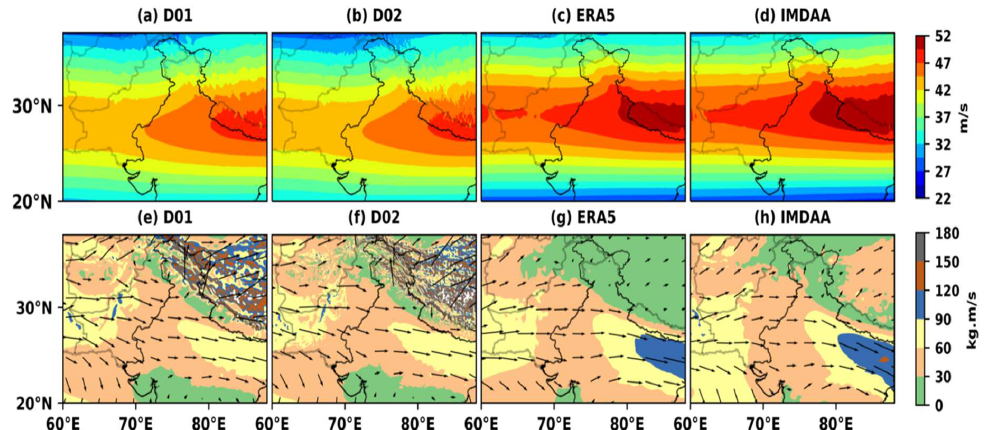
Figure 7. Seasonal averaged zonal winds at 200 mb in model D01 ( a ) and D02 ( b ) and observation ERA5 ( c ) and IMDAA ( d ). Seasonal averaged vertically integrated moisture transport between 1000 and 300 mb in model D01 ( e ) and D02 ( f ) and observations ERA5 ( g ) and IMDAA ( h ).